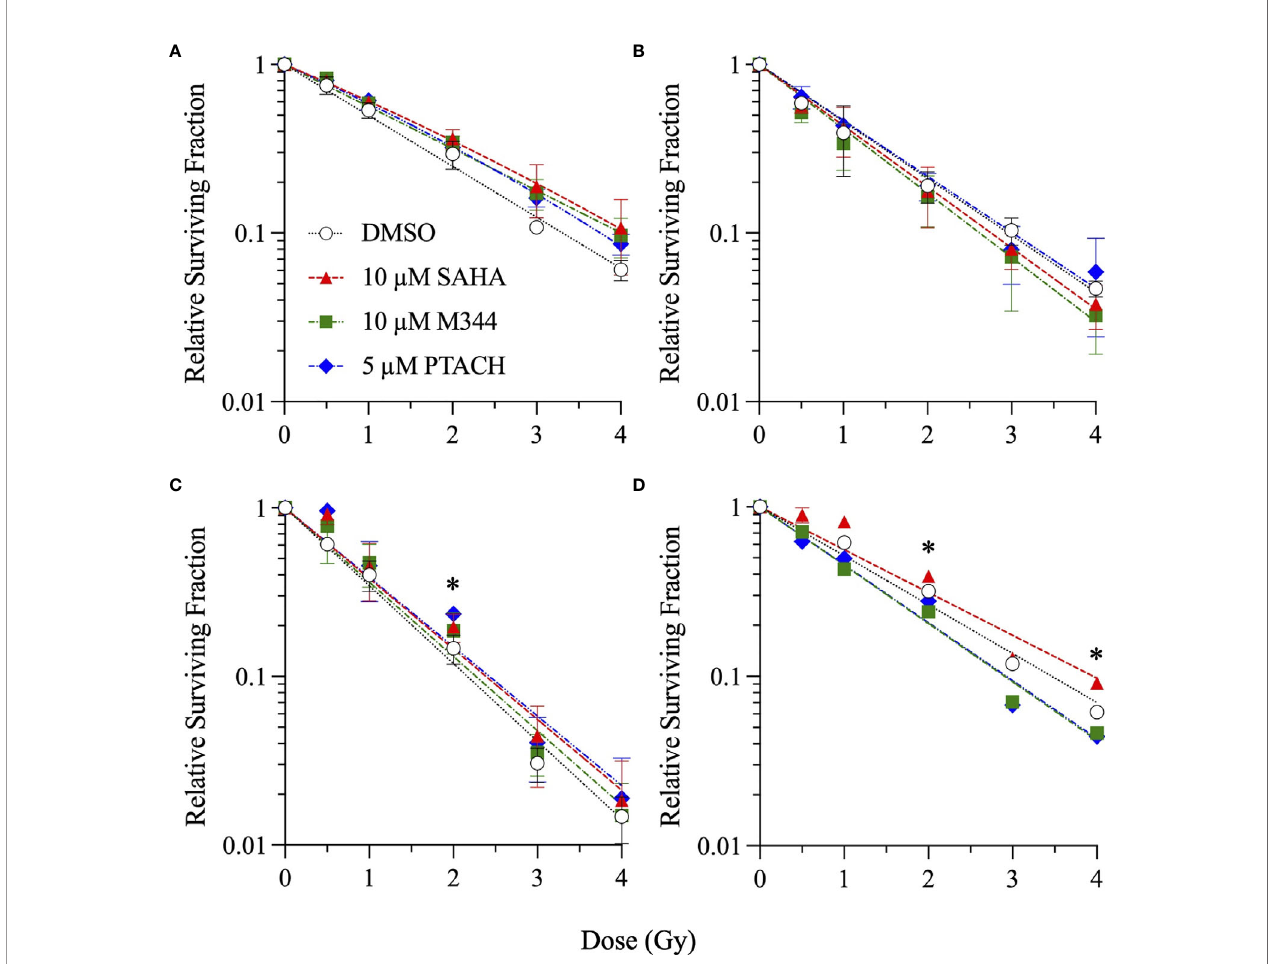
FIGURE 3 | Clonogenic survival of G0/G1-phase normal NFF28 primary fi broblasts (A) and asynchronously growing A549 lung carcinoma (B) , U2OS osteosarcoma (C) , and U87MG malignant glioma cells (D) pretreated for 18 h with 10 µM SAHA, 10 µM M344, or 5 µM PTACH and exposed to 0.5 – 4 Gy 290 MeV/n C-12 ions in the Bragg plateau region (LET = 13.02 keV/µm). Data reported as mean ± SD; where error bars are not visible, they are smaller than the data point. Asterisks mark signi fi cant differences compared to DMSO controls at p -values of ≤ 0.05 (*) by one-way